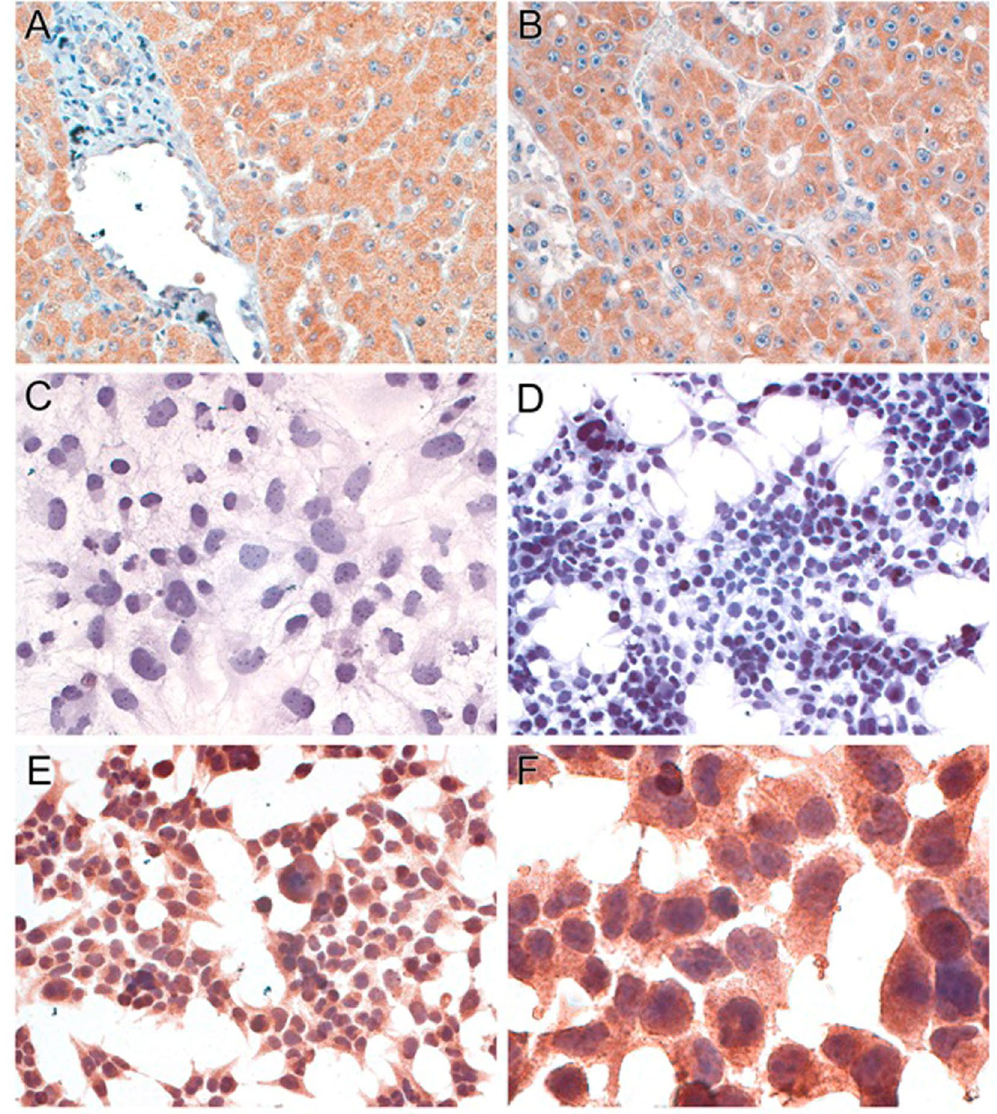
Figure 4. Immunohistochemistry for UQCR10 expression. Panel (A) (original magnification, 160 × ), Non- neoplastic hepatocytes express UQCR10; Panel (B) (160 × ), Hepatocellular carcinoma expresses UQCR10; Panel (C) (160 × ), Wild type Huh7 cell lines have little or no UQCR10 expression; Panel (D) (100 × ), Wild type HepG2 cell lines have little or no UQCR10 expression; Panel (E) (160 × ), HepG2 cells obtained at the end of the assay express UQCR10; Panel (F) (400 × ), Higher magnification from same cells in panel E showing granular cytoplasmic